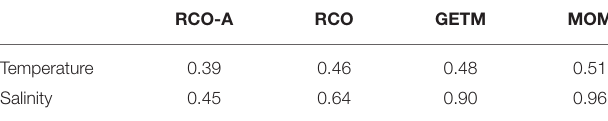
TABLE 1 | Mean cost function values CM for temperature and salinity determined from Equation 2 for the ocean models RCO-A, RCO, GETM, and MOM. RCO-A RCO GETM MOM Temperature 0.39